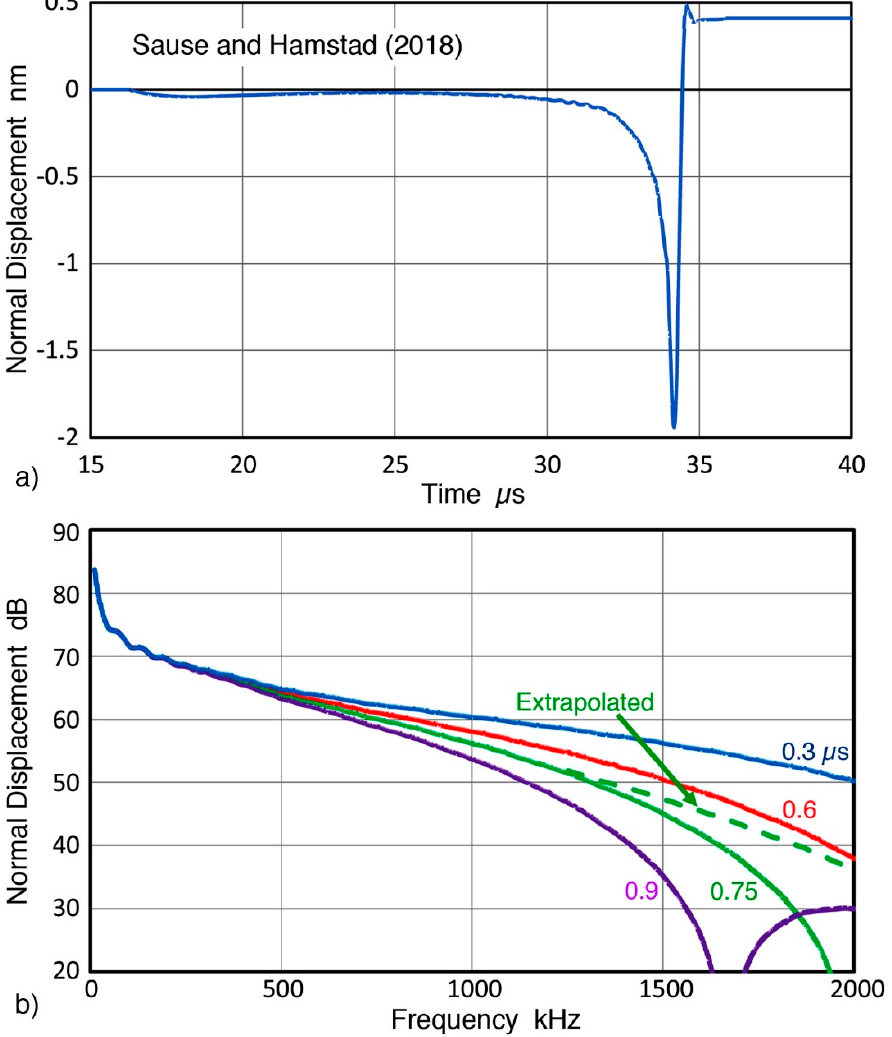
Figure 7. ( a ) Calculated and verified surface normal displacements from a GC fracture [23]. ( b ) FFT spectra of displacement function in Figure 5a with 0.3 µs rise time and its longer rise time modifications with 0.6, 0.75, and 0.9 µs. An extrapolated spectrum for 0.75 µs curve is given by green dash curve.